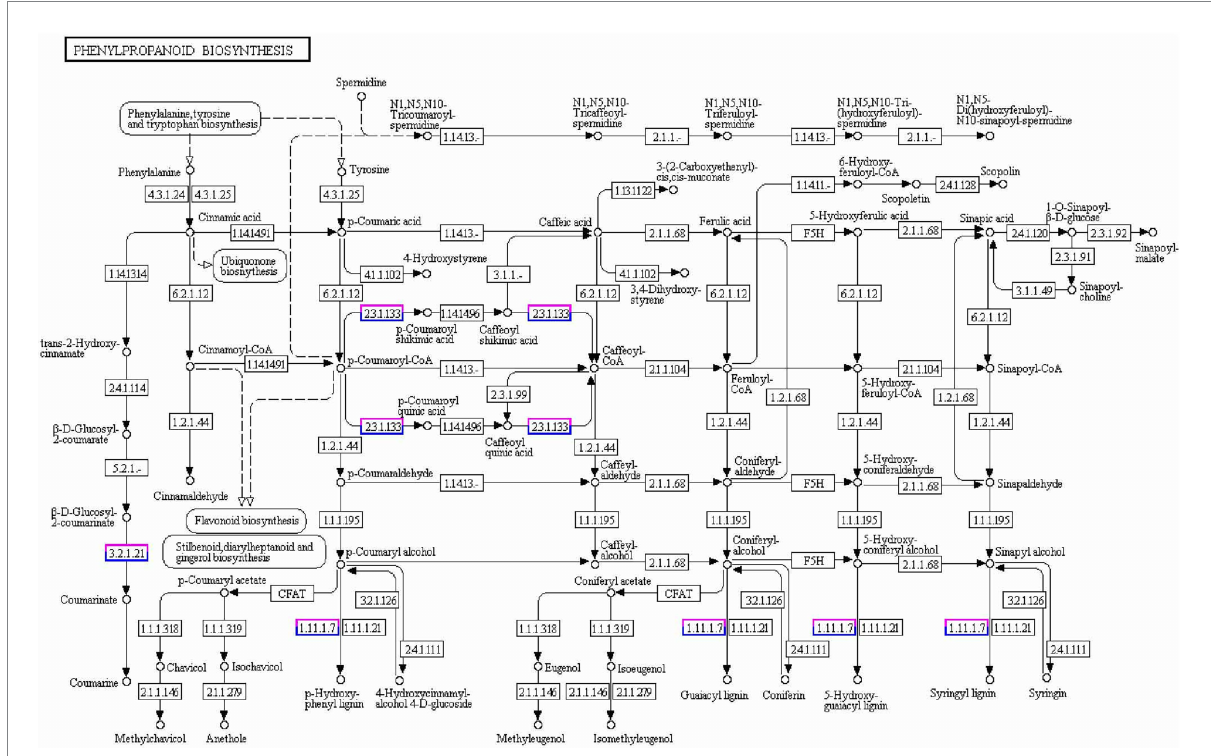
FIGURE 6 Phenylpropanoid biosynthesis pathways including DEPs and DEGs for wheat radicle length. Red frames are annotated metabolic pathway targets with DEPs, and blue frames are annotated metabolic pathway targets with